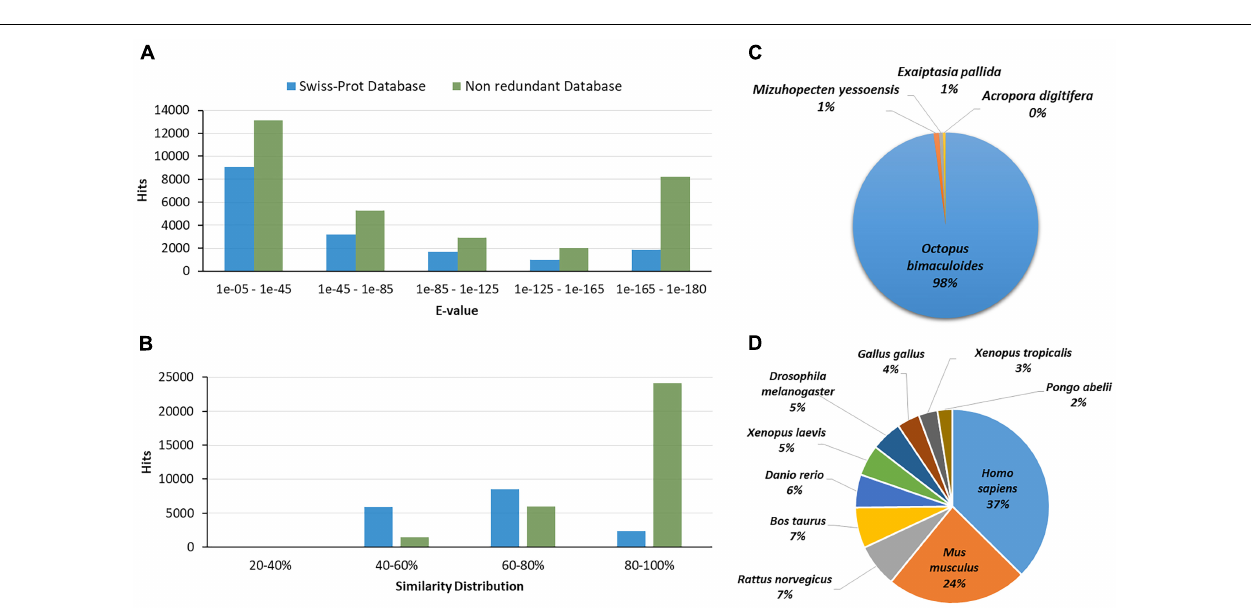
FIGURE 1 | (A) Venn diagram of the number of transcripts expressed in the reference testis transcriptome of Octopus maya in each treatment. (B) Venn diagram of DETs with significant higher expression in each treatment. Treatments: 24PRE – control treatment exposed to 24 ◦ C; 24POST – mated and exposed to 24 ◦ C; 30PRE – exposed to 30 ◦ C; 30POST – mated and exposed to 30 ◦ C.